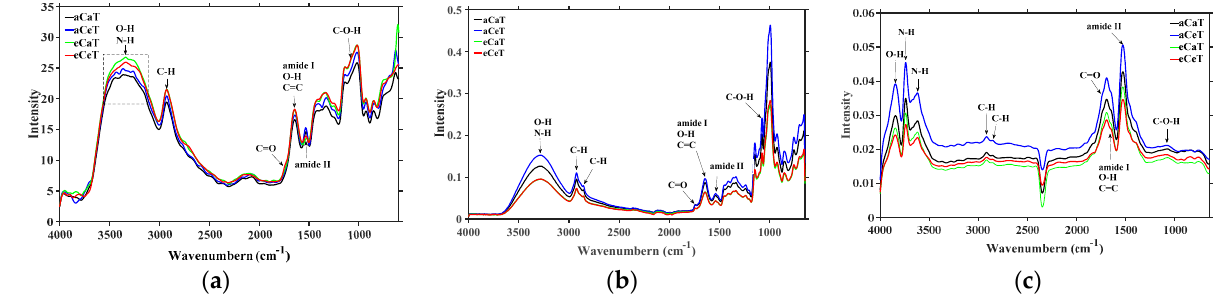
Figure 2. Averaged spectra of ( a ) Fourier transform infrared photoacoustic spectroscopy (FTIR-PAS), ( b ) Fourier transform infrared attenuated total reflectance spectroscopy (FTIR-ATR), and ( c ) Fourier transform infrared diffuse reflectance spectroscopy (DRIFTS) of rice samples under different treatments. Note: aCaT, aCeT, eCaT, and eCeT refer to ambient conditions, increased temperature, elevated CO 2 , and the combination of elevated CO 2 and increased temperature, respectively.